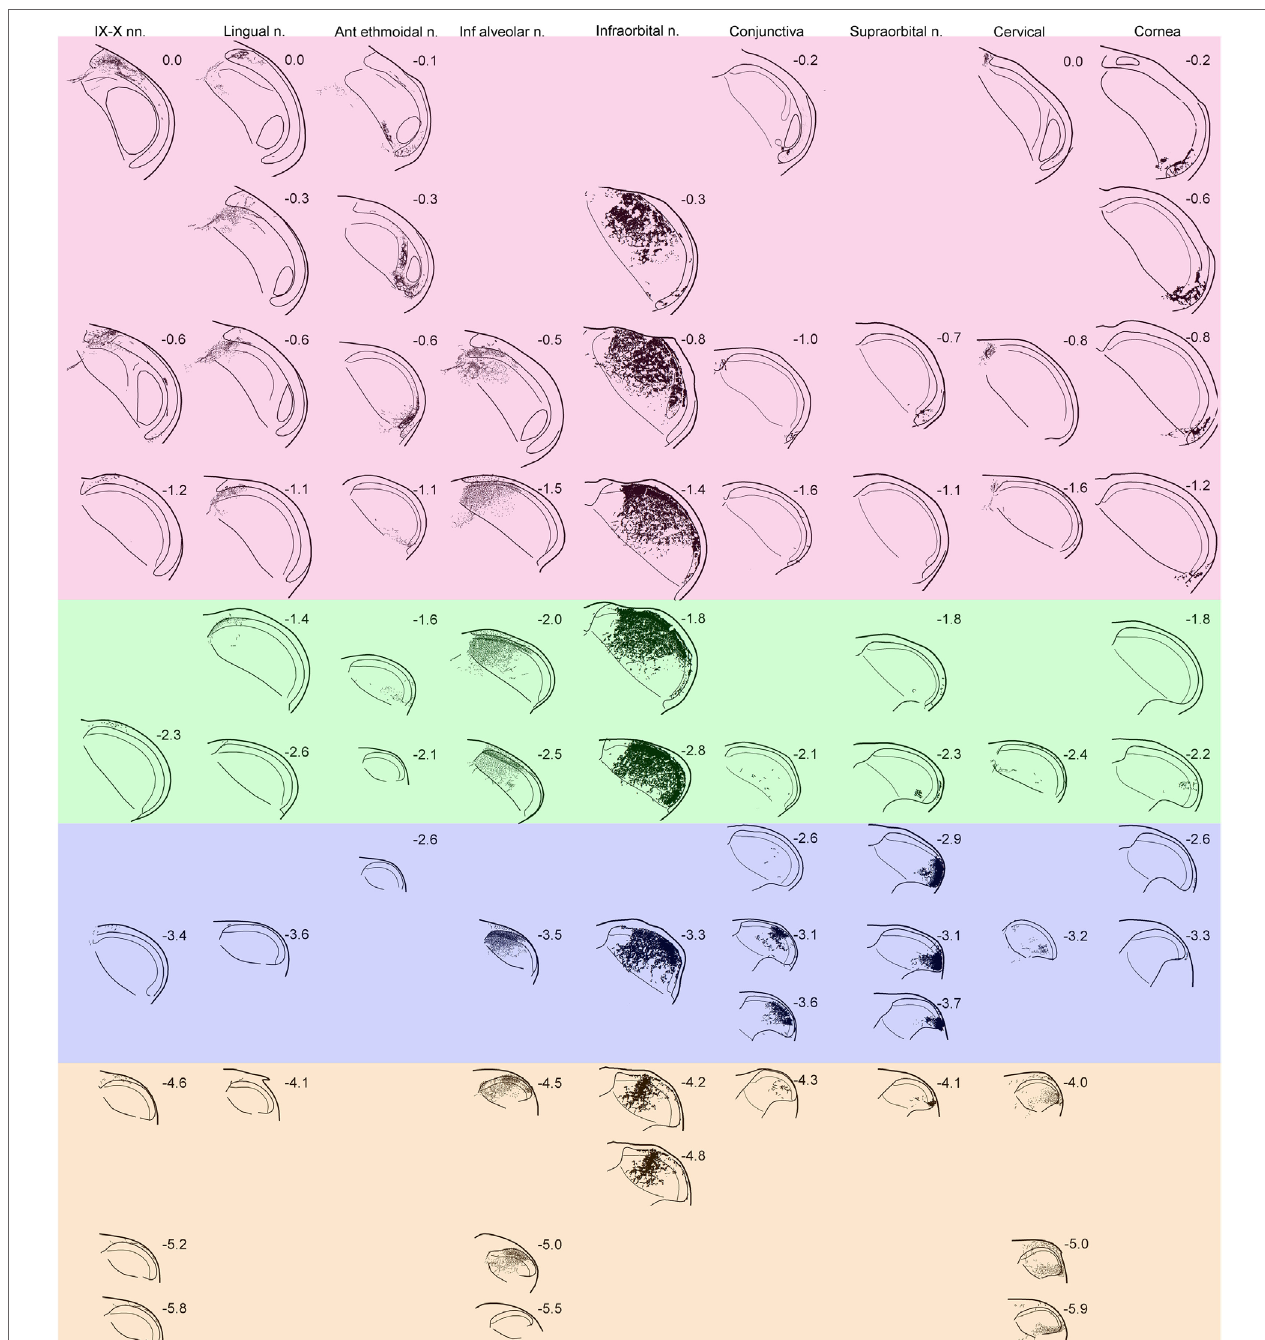
FigUre 1 | Line drawings showing the distribution of reaction product in the trigeminocervical complex after transganglionic transport of an horseradish peroxidase (HRP) cocktail of tracers injected into individual nerves/receptive fields. Drawings are arranged with rostral sections placed near the top of the figure while more caudal sections are shown near the bottom. Note that nerves/receptive areas innervating glabrous surfaces, e.g., IX–X, lingual, anterior ethmoidal, conjunctiva and cornea, project mostly to laminae I, II, and V, while those innervating hairy skin, e.g., inferior alveolar, infraorbital, supraorbital, and cervical, densely project to all laminae. Bands of color have been arbitrarily superimposed over these drawings; compare these to similarly colored bands on Figure 5 . While all nerves have appropriate central projections to areas of the trigeminocervical complex known to represent V1, V2, and V3 divisions of the trigeminal nerve, the rostrocaudal distribution of the reaction product from different nerves imply the existence of “cranial dermatomes.” Note the progression of reaction product in the trigeminocervical complex from nerves innervating oral and perioral areas rostrally (upper left corner of figure with red hue) toward those innervating the snout (in the middle shaded green), periocular areas (in the middle shaded blue), to finally cervical dermatomes (in the lower right corner shaded orange). The central representation of the cornea, however, defies the maps order and is drawn as the last column. Numbers adjacent to line drawings represent mm caudal to the obex.